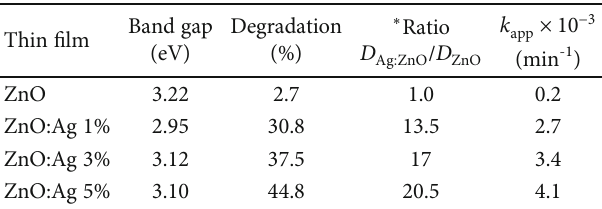
Figure 7: (a) Re fl ectance di ff use spectra for both ZnO and ZnO:Ag thin fi lms. (b) Kubelka-Munk plots and band gap energy estimation for both ZnO and ZnO:Ag thin fi lms. Table 2: Optical and kinetic results for both ZnO:Cu and ZnO:Co thin fi lms.